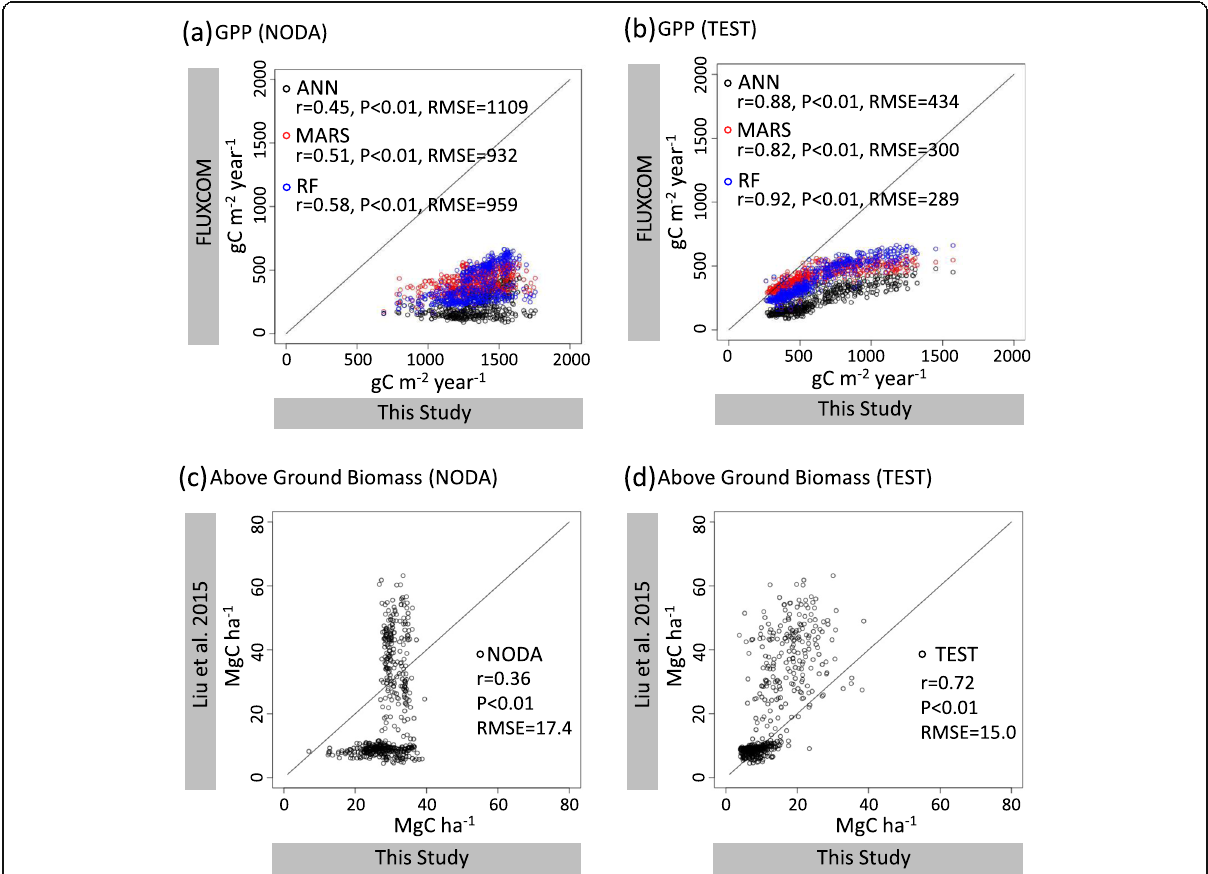
Fig. 5 Spatial correlation coefficients between this study and the previous studies. The upper panels display the scatter plots of GPP of this study against that of FLUXCOM for NODA ( a ) and TEST ( b ): the artificial neural network (ANN), multivariate regression splines (MARS), and random forest (RF) (Tramontana et al. 2016; Jung et al. 2017), with the observation threshold of Reichstein et al. (2005). The lower panels display the scatter plots of aboveground biomass of this study against that of Liu et al. (2015) for NODA ( c ) and TEST ( d